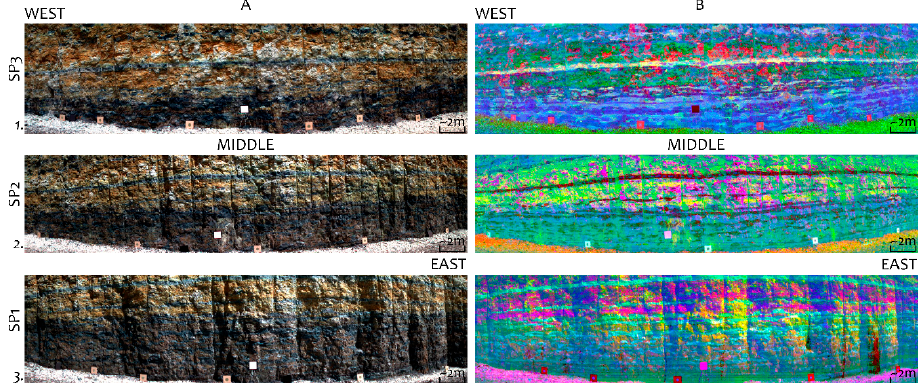
Figure 12. ( A ) False color hyperspectral images of the roadcut along US-71 Hwy near Pineville from scan positions 3 to the West to 1 to the East (SP3-SP1), spectral bands 1086, 1554, and 2033 nm are displayed in red, green, and blue (RGB). ( B ) False color Maximum Noise Fraction (MNF) images based on (A) with bands (5, 1, and 2), (6, 5, and 2), and (5, 2, and 6) displayed in RGB for SP3 to SP1, respectively.